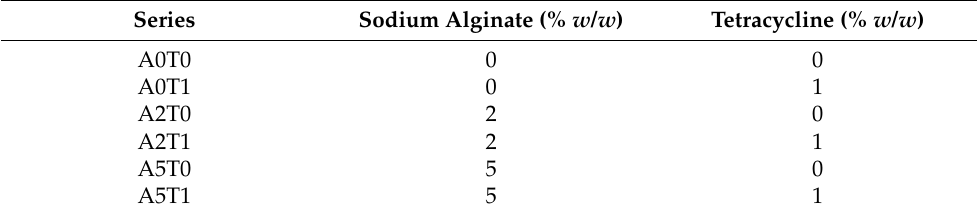
Table 7. Experimental design, MCPM/ β -TCP = 45/55%. Liquid phase = 0.5